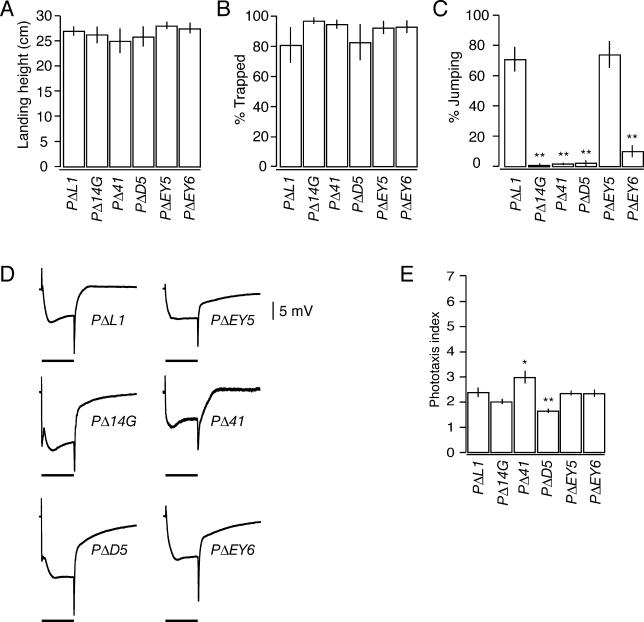
Behavioral Characterization ofDα7 MutationsThe response of flies in a variety of behavioral assays is shown in this figure. The error bars represent SEM. In all assays, the precise excision of P-element line KG3295,PΔL1, served as a control for the mutant linesPΔ14G, PΔ41, andPΔD5. The precise excision of line EY10801,PΔEY5, served as a control forPΔEY6.(A) Flight test. Flies were individually dropped in a plastic cylinder, and the height at which they landed was recorded. Ten flies were tested for each genotype.(B) Olfactory response. Ten flies were placed in a Petri dish containing traps baited with food, and the number of trapped flies was recorded. Averages were calculated from between eight and ten trials for each genotype.(C) Visually mediated jump assay. Flies were placed in a Petri dish illuminated with green LEDs. A lights-off stimulus was presented by turning off the LEDs for 20 ms. For this assay it was necessary to use white-eyed flies. SincePΔEY5 andPΔEY6 are red-eyed, we placed them in abw; st background, which produces white-eyed flies.p-Values:PΔ14G, 1.9 × 10−6 (n = 9);PΔ41, 1.9 × 10−6 (n = 11);PΔD5, 1.9 × 10−6 (n = 9);PΔEY6, 1.9 × 10−6 (n = 7).(D) Representative ERGs are shown for control and mutant alleles. We recorded extracellular responses from the eye to 1-s pulses of white light. The timing of the light pulse is shown below each voltage trace.(E) Visual performance was tested using the counter-current assay of Benzer [29].p-Values:PΔ14G, 0.22 (n = 5);PΔ41, 0.02 (n = 5);PΔD5, 0.003 (n = 5);PΔEY6, 1 (n = 5).